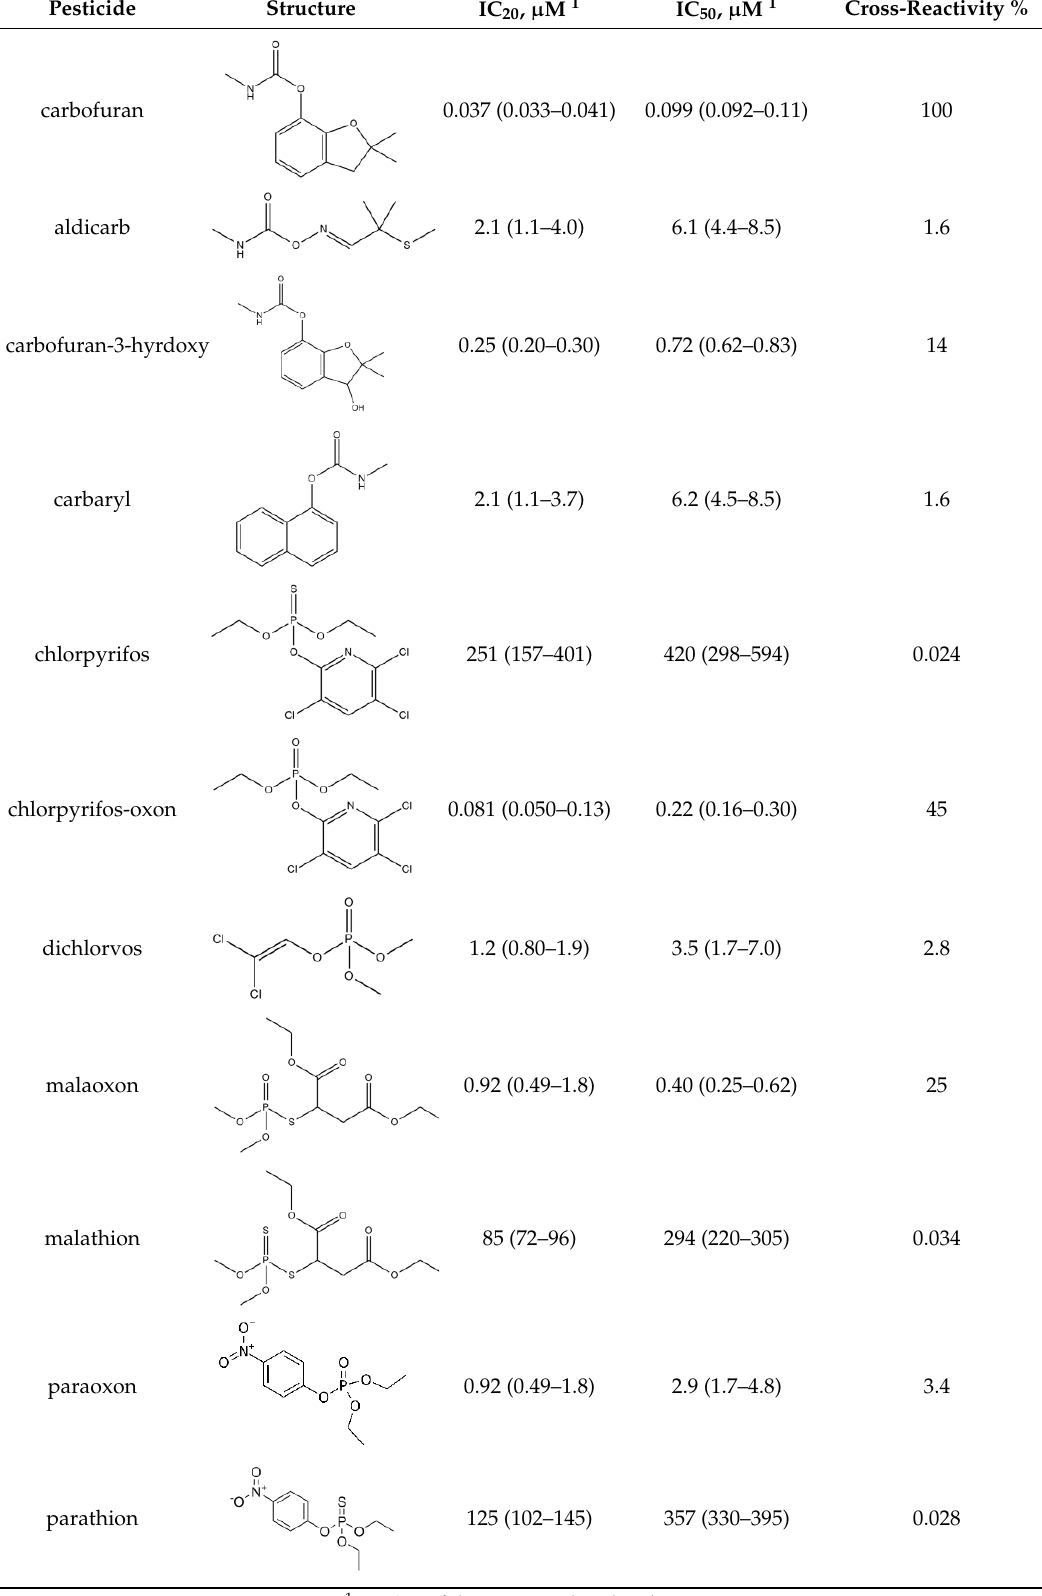
Table 2. Inhibitory strength of tested CMs and OPs in terms of IC 20 and IC 50 and AChE specificity towards carbofuran in terms of cross-reactivity %.